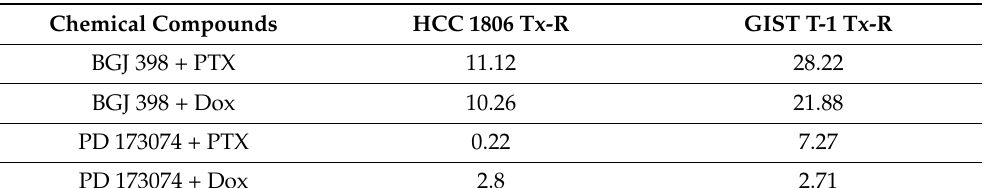
Table 2. Synergy scores between FGFR inhibitors and chemotherapeutic agents in Tx-R HCC 1806 and GIST T-1 cell lines.